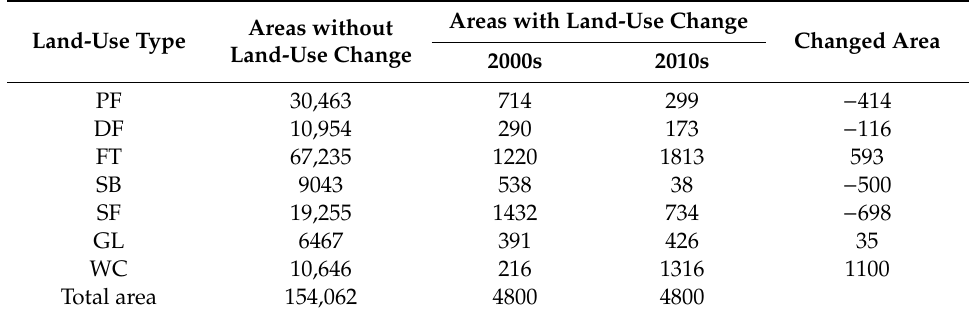
Figure 8. Spatial distribution of significant correlation ( p < 0.05) between annual vegetation net primary productivity (NPP) and the three meteorological factors. The subplots in the right column are the enlarged images of the area where the corresponding black dots are located in the left figure. Table 2. Composition and change of land use during the two periods in the Poyang Lake basin (Unit: km 2